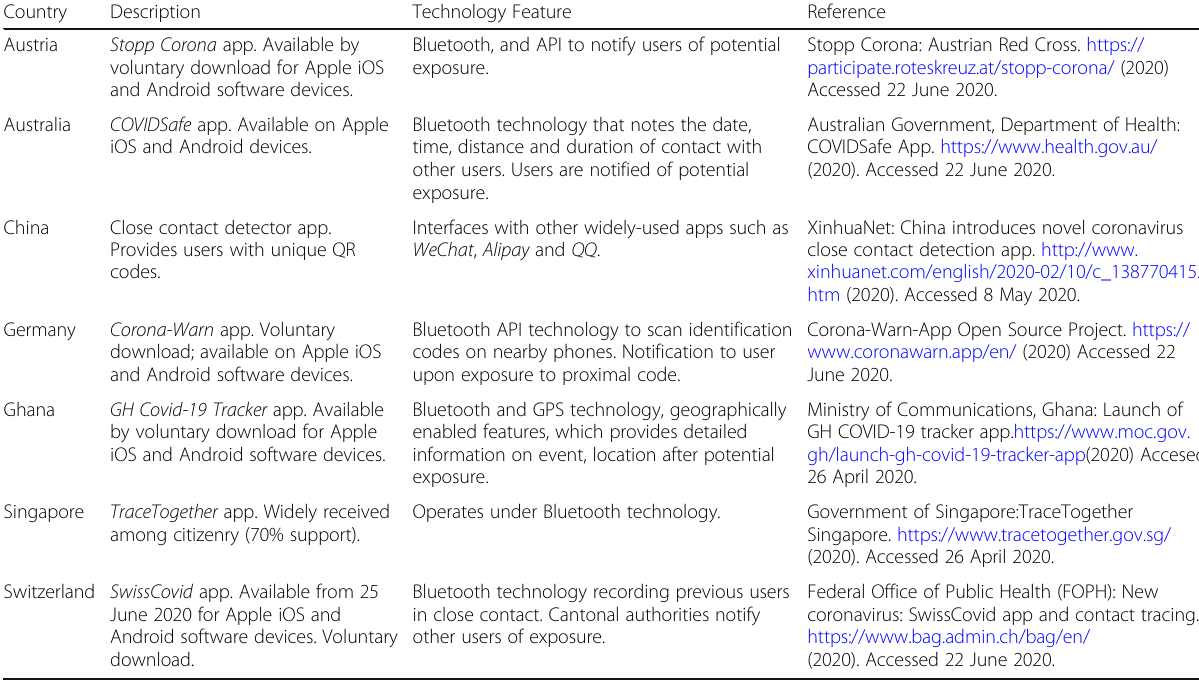
Table 1 Worldwide implementation of digital health technology for COVID-19 contact tracing